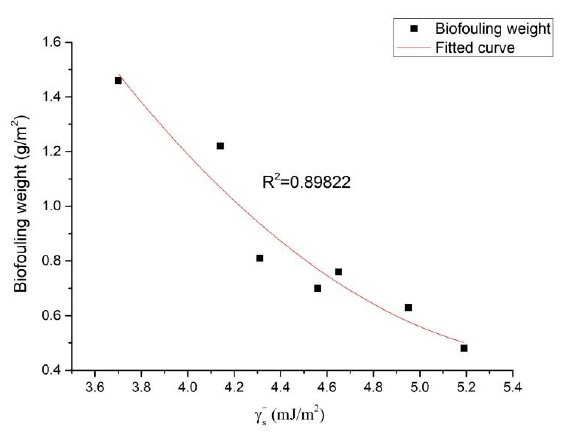
ff ect of the surface energy component on the weight of the iron bacteria Figure 7. Effect of the surface energy component on the weight of the iron bacteria biofouling. Figure 7. E